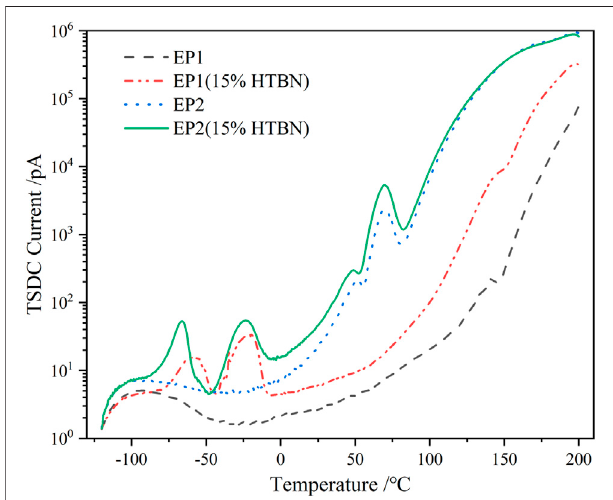
FIGURE 7 | TSDC spectra under different